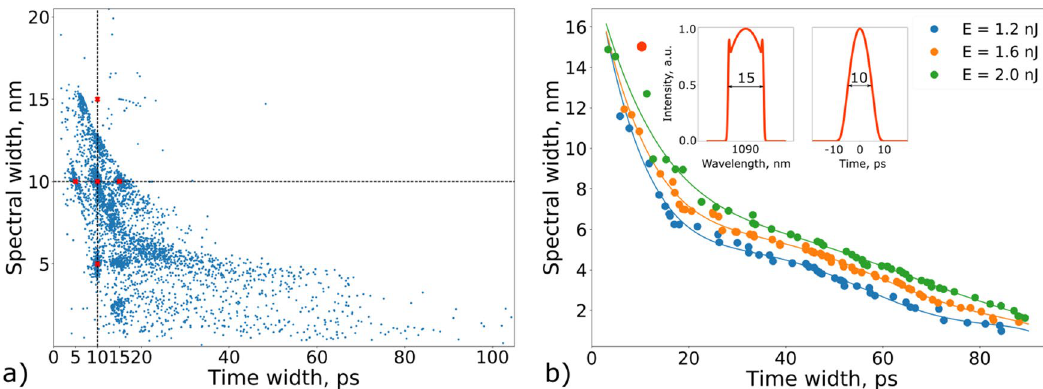
Figure 3. ( a ) Visualization of all obtained stable regimes obtained during the PSO algorithm execution. Each blue dot on the graph corresponds to a certain laser output with the given bandwidth and pulse width. Red crosses denote the target parameters that were set to the PSO algorithm. ( b ) Colored dots correspond to the boundaries (in the space of parameters) of the regimes, the energy of which does not exceed 1.2 nJ (blue dots), 1.6 nJ (orange dots) and 2.0 nJ (green dots). Lines have been obtained as the approximation by polynomials of the 5th degree for each set of these points. Inset shows spectrum and temporal profile corresponding the the red circle (bandwidth of 15 nm and pulse width of 10